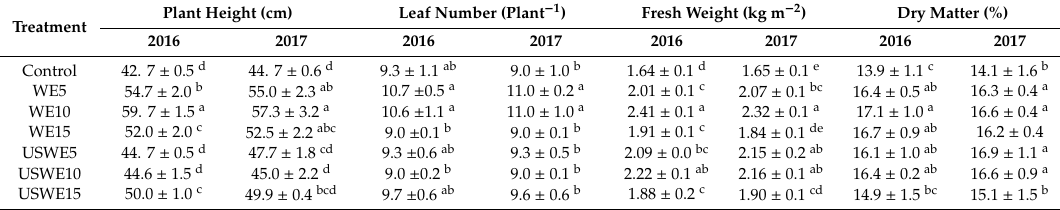
Table 2. E ff ects of water extract (WE) and ultrasound-assisted Water Extraction (USWE) on growth characteristics of Jew’s Mallow during 2016 and 2017 growing